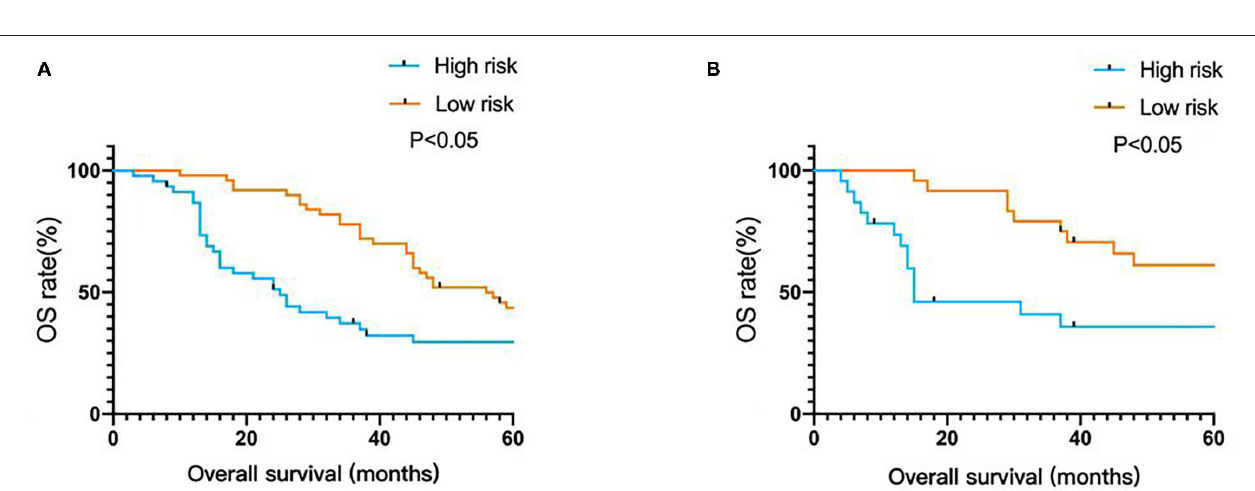
FIGURE 5 | Kaplan-Meier survival curves of nomogram. (A) In the development cohort. (B) In the validation